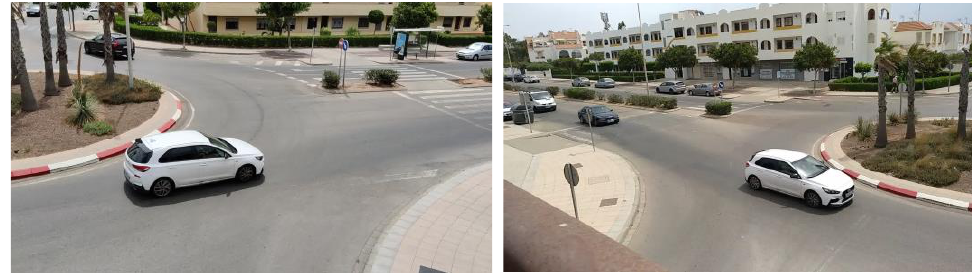
Figure 13. Operational Urban Dataset sample.